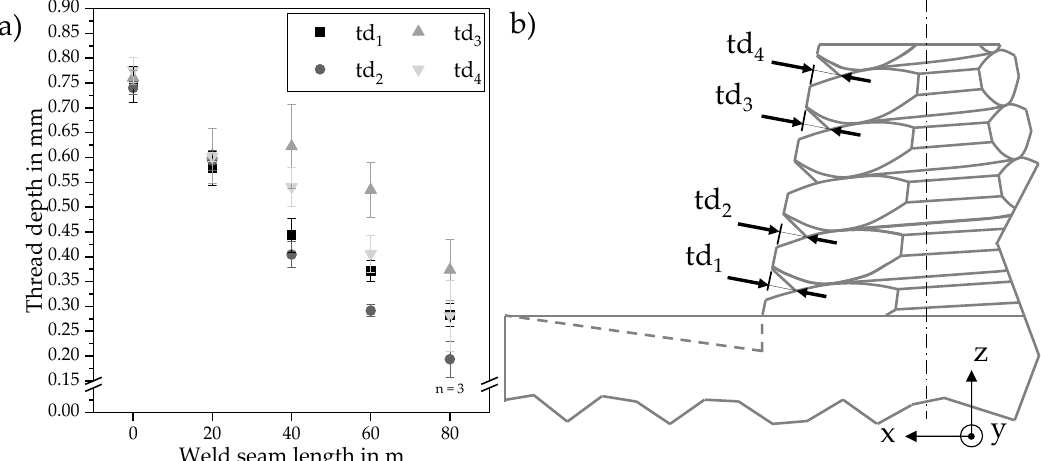
Figure 9. Wear behavior of the thread depth as a function of the weld seam length in ( a ) measured with the stripe light projection and ( b ) at the measuring points.